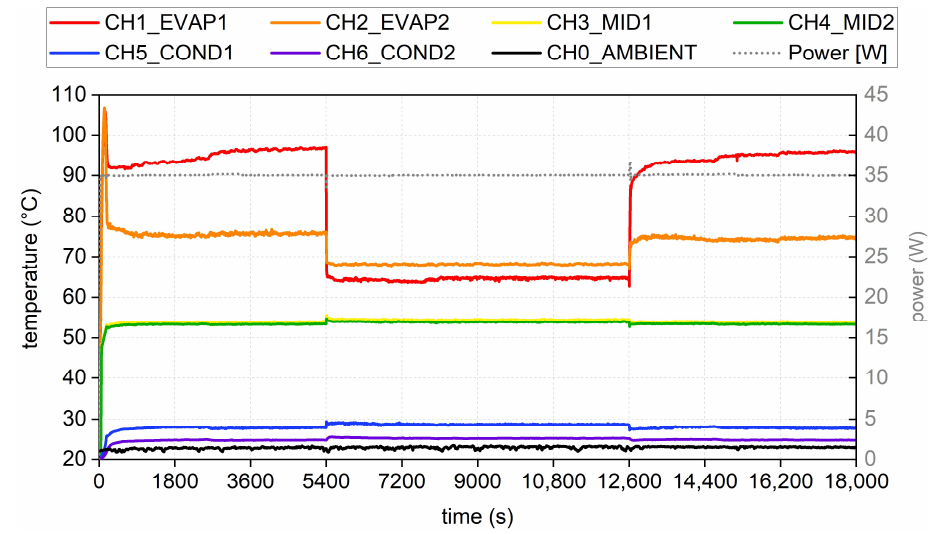
Figure 5. Measured temperatures of initially switched off thermosiphon upon switching on at 5400 s and switching off at 12,600 s during constant heating with 35 W.